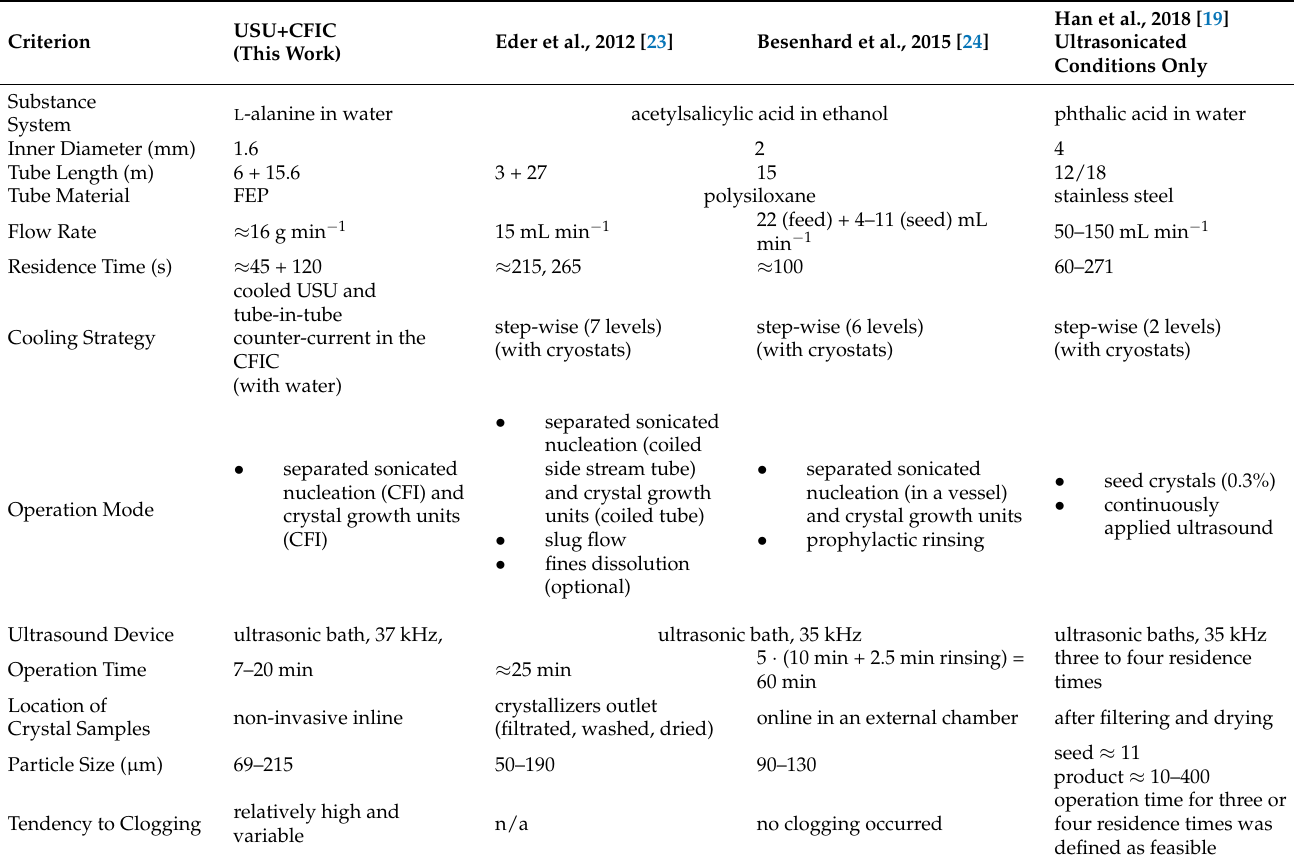
Table 6. Comparison between continuous nucleation and crystal growth experiments for different coiled